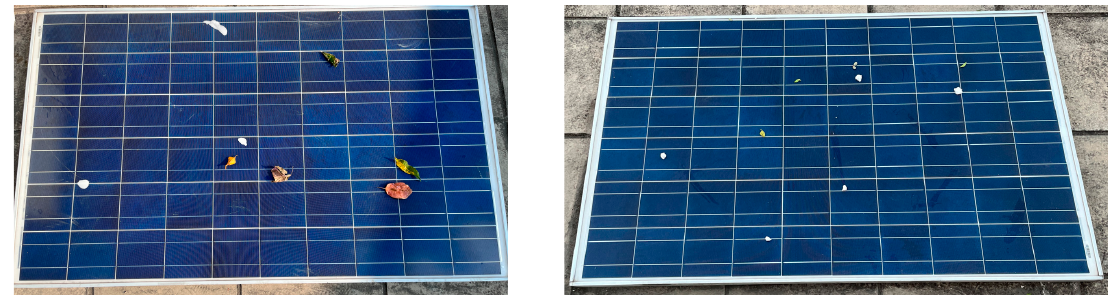
Figure 10. Schematic diagram of AOD dataset model.